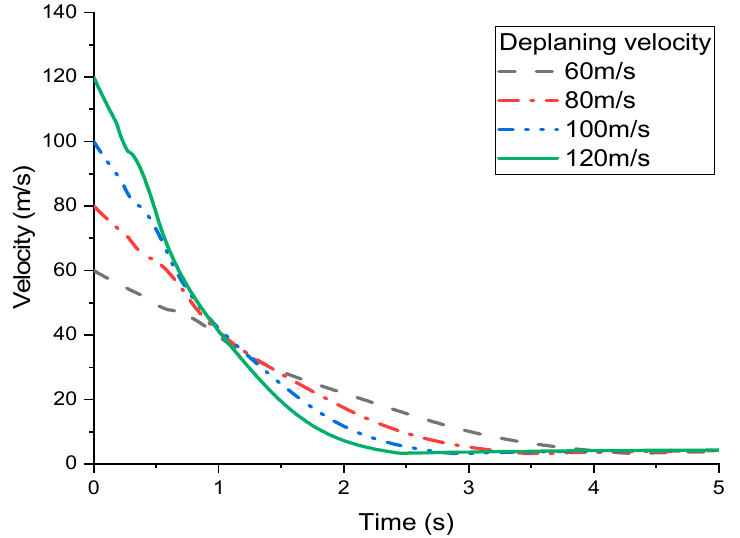
Figure 7. Velocity changes of parachute airborne systems at different deplaning velocities.